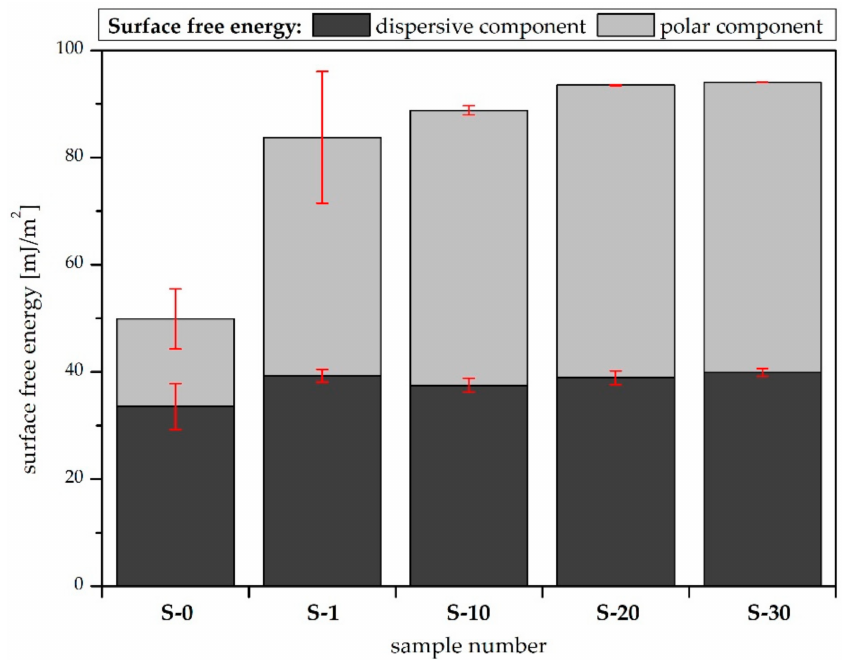
Figure 5. Components of the surface free energy calculated using the LWAB